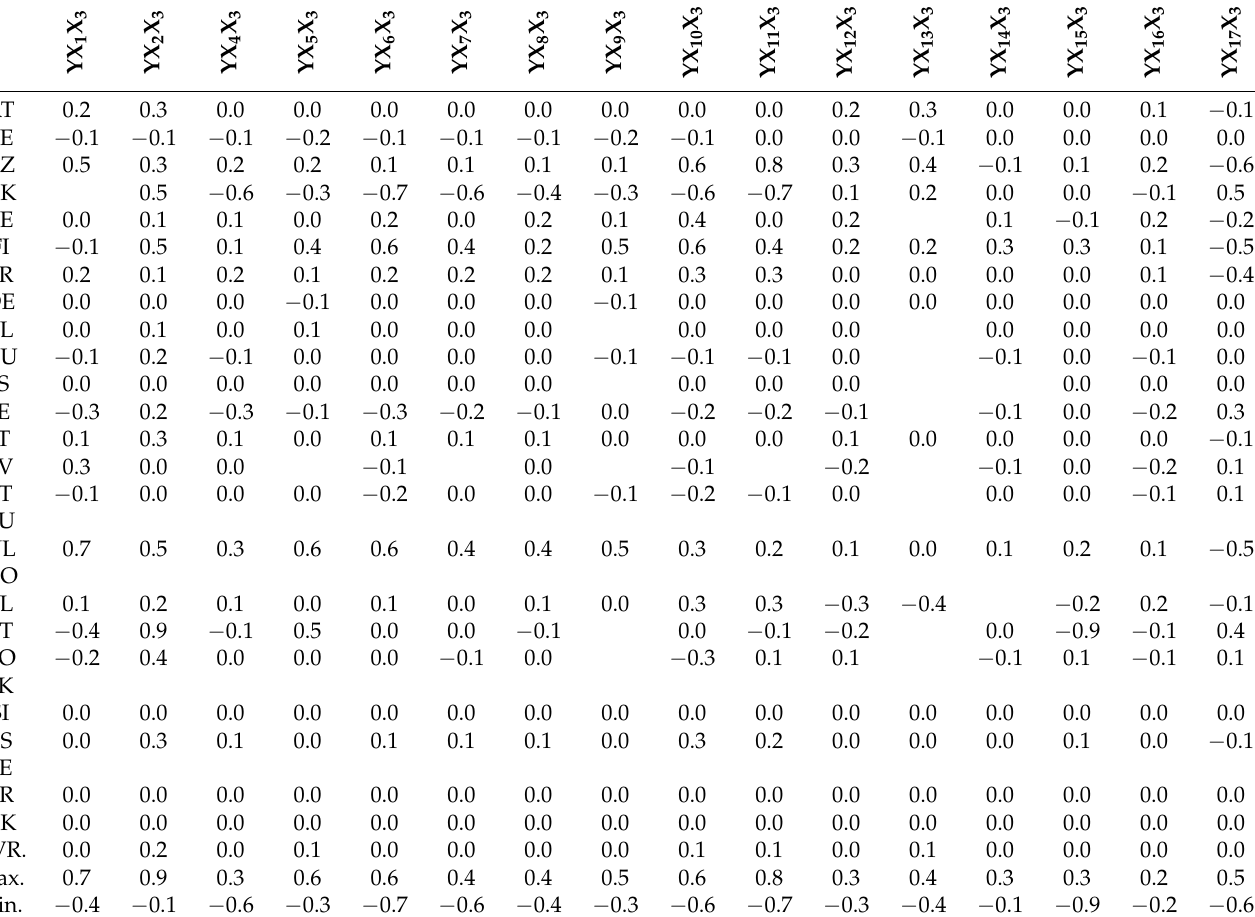
Table 9. Tri-dimensional synergy—YX i X 3